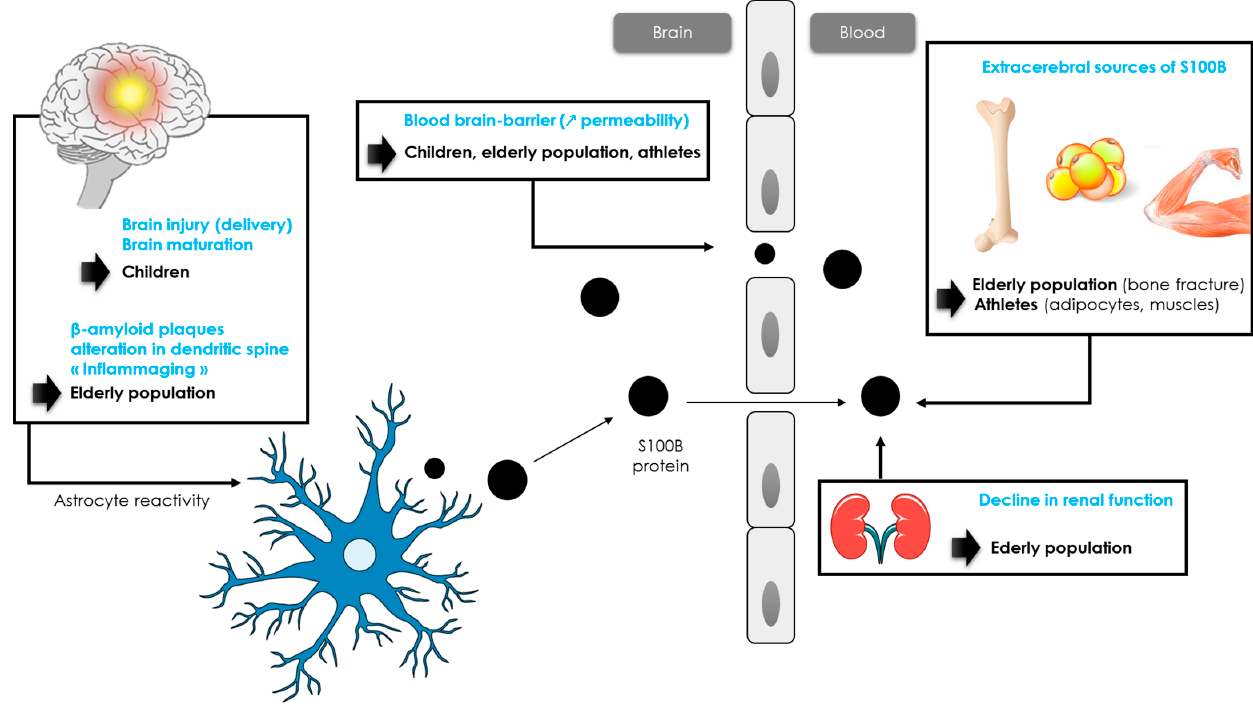
Figure 2. Hypotheses of S100B protein increase in children, athletes and elderly population.